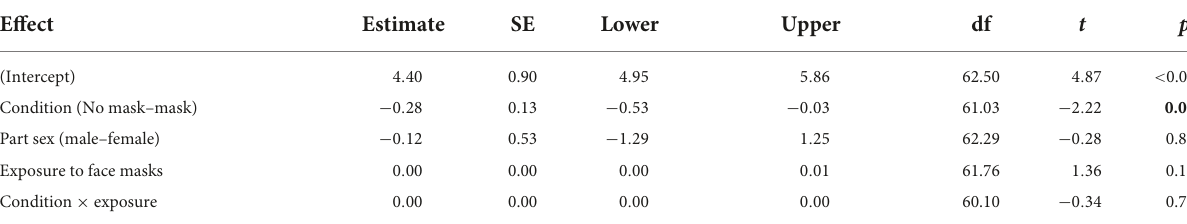
TABLE 1 Fixed effects parameter